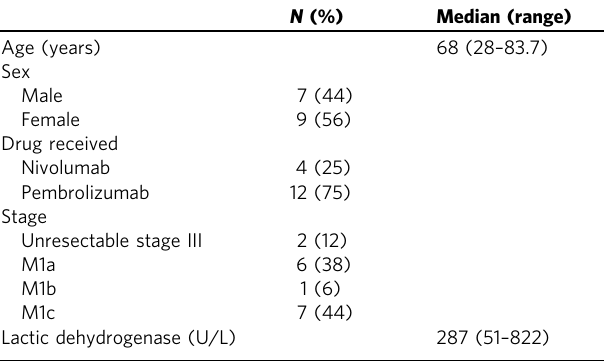
Table 1 Training cohort clinical